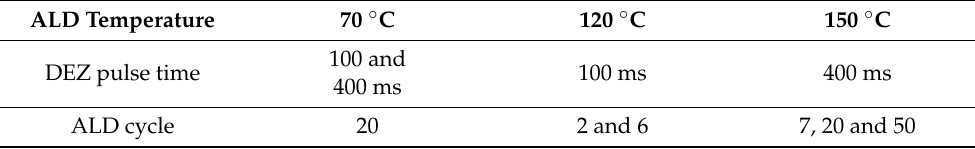
Figure 1. Schematic illustration of ALD coating and EDLC cell modified with crystalline ZnO. Table 1. Activated carbon electrodes subjected to various ALD ZnO coating schemes.